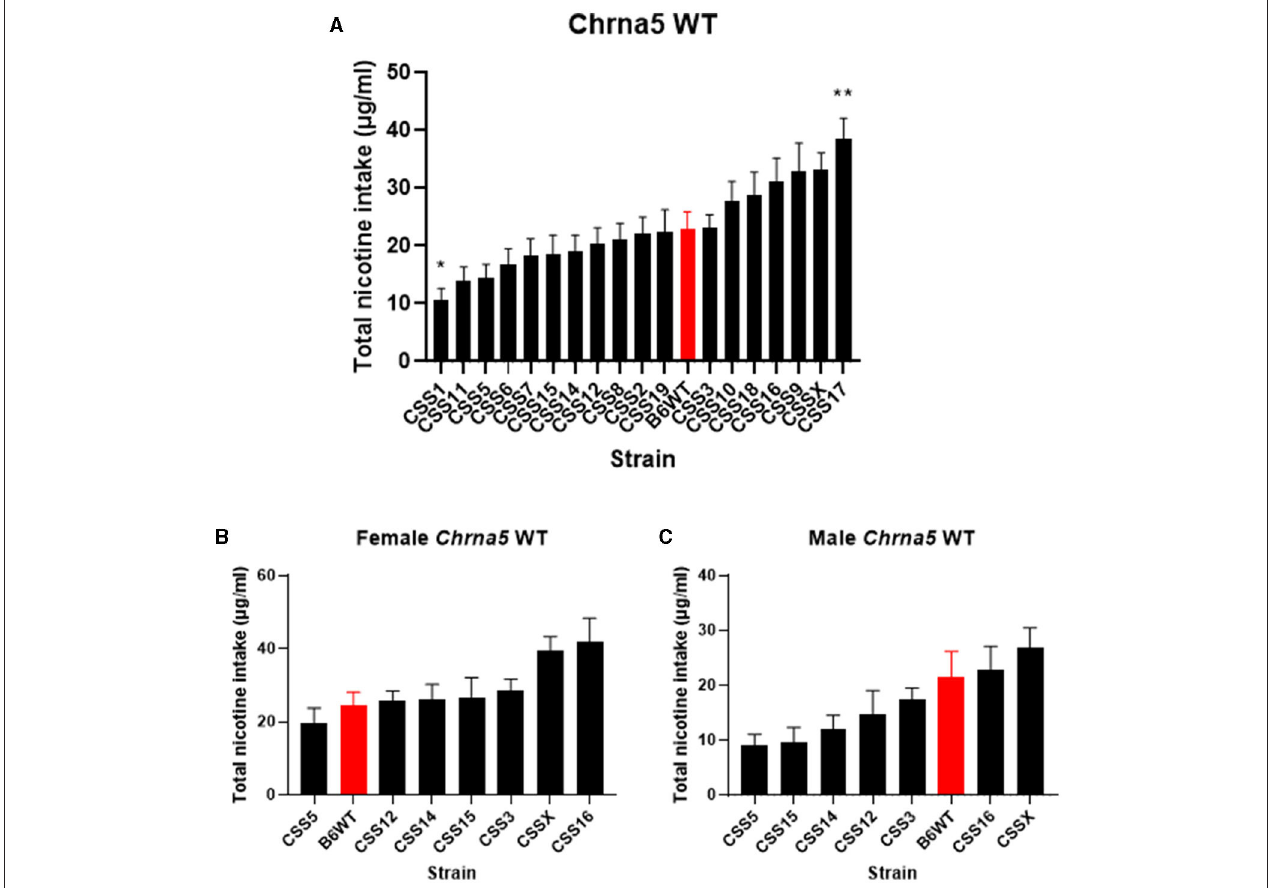
FIGURE 4 | Within Chrna5 WT genotype comparison of nicotine consumption between individual CSS Chrna5 WT and B6 Chrna5 WT mice (B6WT). (A) Shows total nicotine consumption for all strains collapsed on sex (A) . For those strains in which there was a main effect of sex, data are shown separately for female (B) and male (C) animals. * q < 0.05, ** q < 0.01 for pairwise comparison of nicotine consumption between CSS Chrna 5WT and B6 Chrna 5WT . Data shown represent mean ± SEM. N = 12–17 per strain per